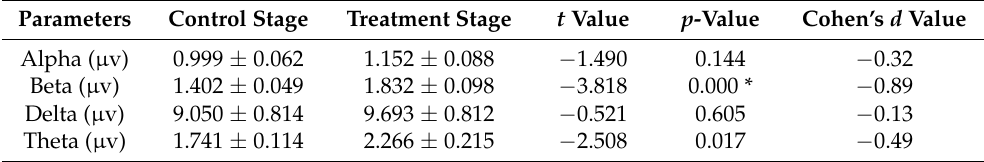
Table 1. Differences in electroencephalogram variables of goats upon exposure to act of slaughter. Parameters Control